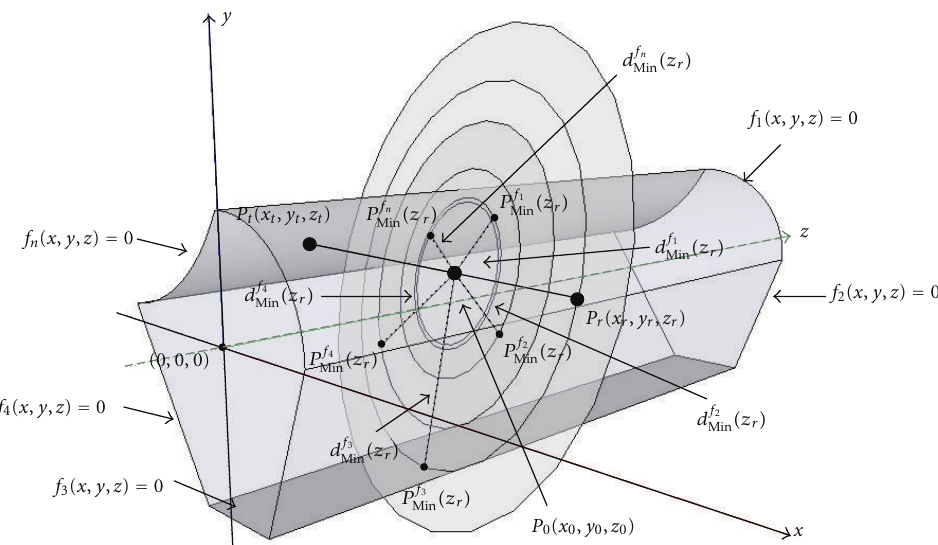
Figure 2: Detailed schematic diagram of the propagation inside arbitrary cross-sectional tunnels with the first Fresnel zone clearance.